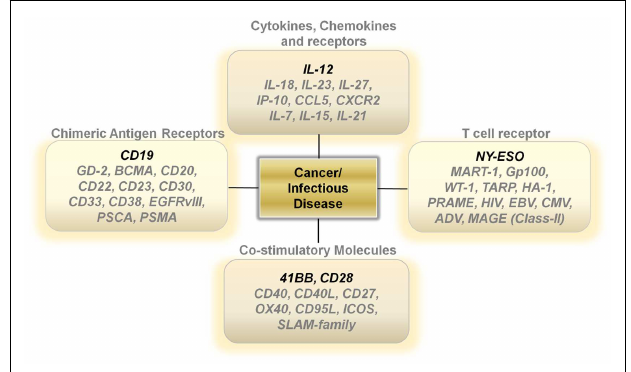
FIGURE 1 | Potential therapeutic gene therapies inT cells for Cancer and Infectious Diseases